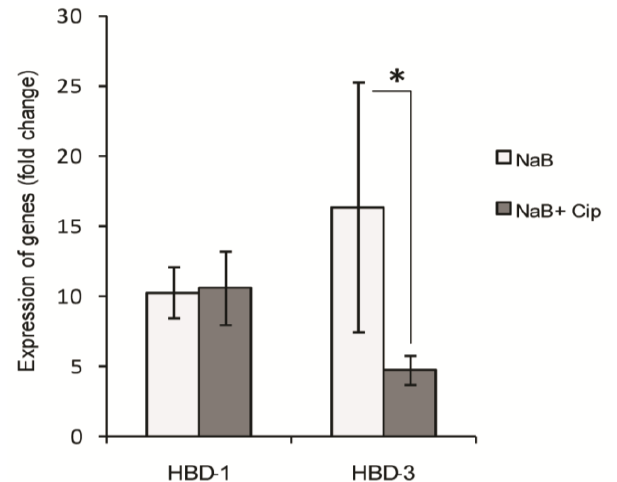
Figure 4. Effect of ciprofloxacin on butyrate-induced expression of HBD-1 and HBD-3 transcripts in HT-29 cells. HT-29 cells were stimulated for 24 h with 2 mM NaB alone or in combination with 150 µg/mL ciprofloxacin. RNA was extracted from cells and cDNA prepared, which was used to quantify expression of HBD-1 and HBD-3 transcripts by real time qPCR. Gene expression is presented as fold change to control (untreated) cells. Data are given as mean ± SD of four replicates. One way ANOVA of log-transformed data was utilized in comparing between different groups. Pair-wise effects between groups were compared by the Holm-Sidak post hoc comparison procedure. * p <